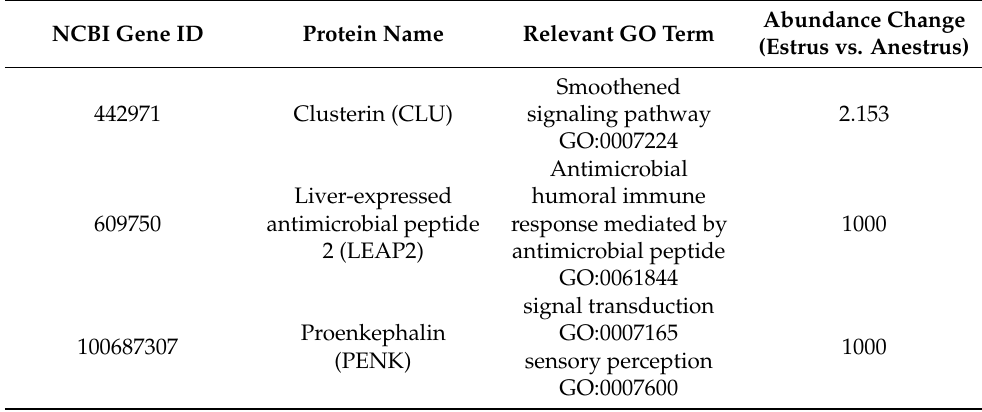
Table 3. List of proteins with significantly affected abundance rates in estrus vs. anestrus samples (identified as involved in response to external